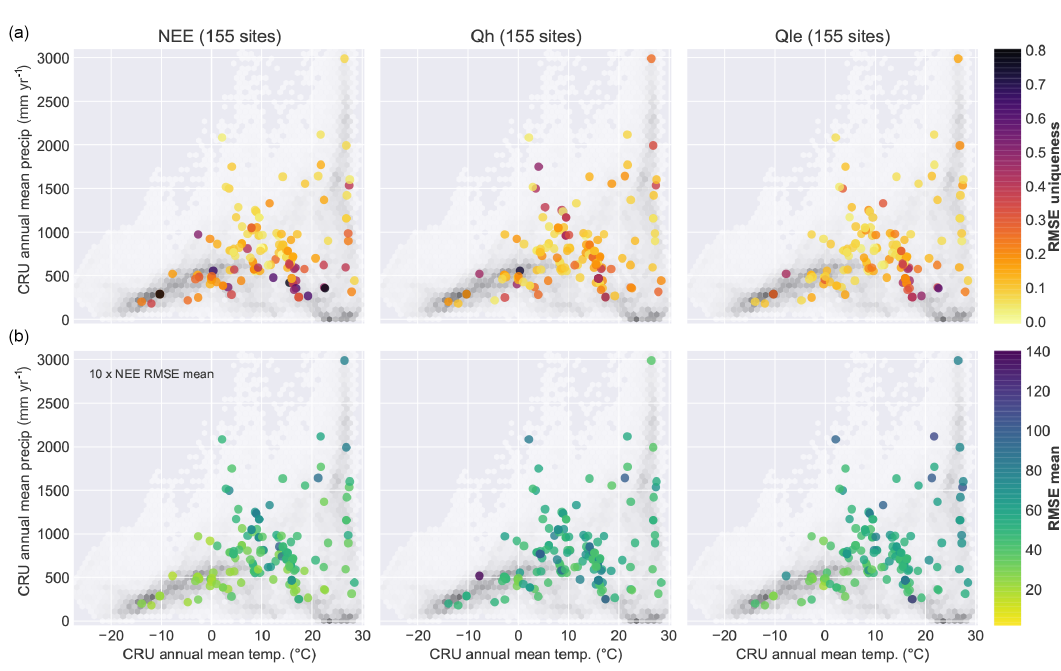
Figure 4. Predictability metrics for mean annual temperature vs. mean annual precipitation (mean across models). Panel (a) is RMSE uniqueness (darker colours indicate a more unique, less predictable site), and panel (b) is RMSE mean performance (darker colours indicate higher overall RMSE). The grey underlying hexbin plot indicates the global distribution of mean precipitation and precipitation from the CRU dataset for all grid cells over land to give an indication of the representativity of these